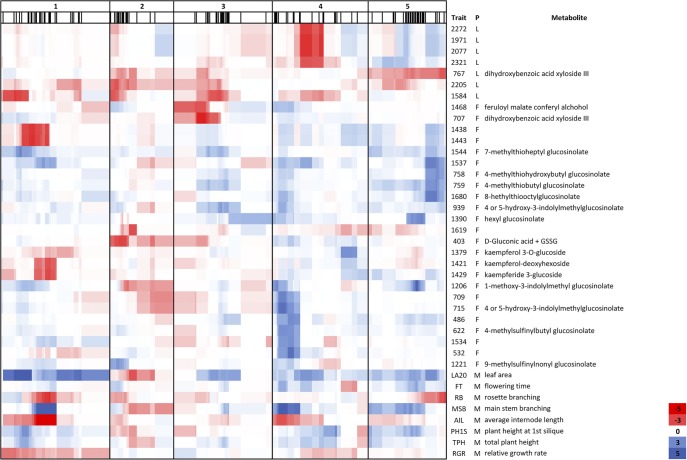
QTLepi heat map for metabolic and morphological traits. QTLepi heat map showing the positions of the QTLepi and the overlap with QTLepi for morphological traits divided over the five chromosomes. The morphological traits were described previously (Kooke et al. 2015). The thin black lines in the second row indicate the marker positions in cM. (Trait) Metabolite number or morphological trait, (P) phenotype group, (L) leaf, (F) flower, (M) morphology. The legend on the right indicates the QTL LOD score between −5 (red) and 5 (blue).